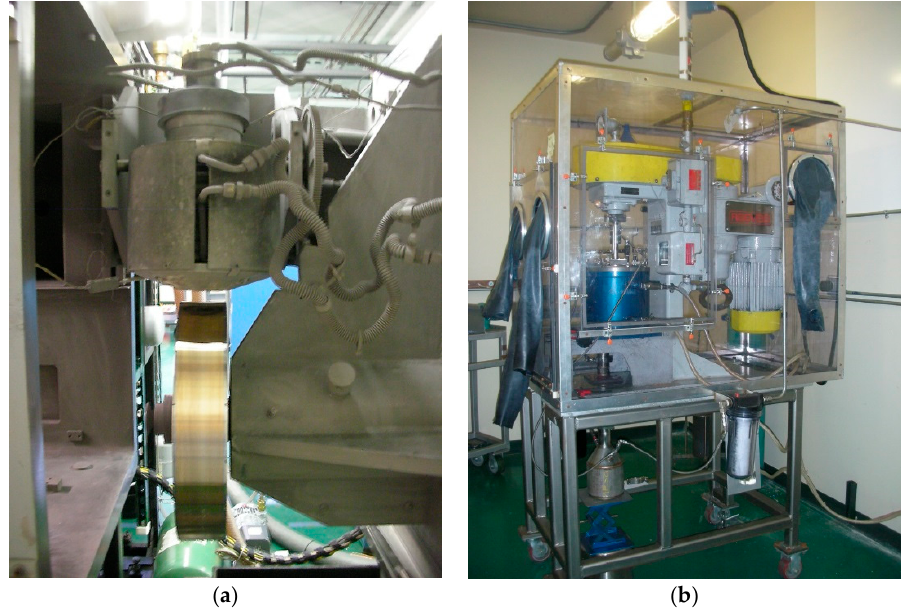
Figure 4. Photos of ( a ) a home-built MS system with a 2 kg induction furnace ( top ) and a rotating copper wheel ( center ) and ( b ) an attritor enclosed in a glovebox filled with argon gas. Powder is collected in a canister ( bottom ) that can be separated from the system by a butterfly valve.